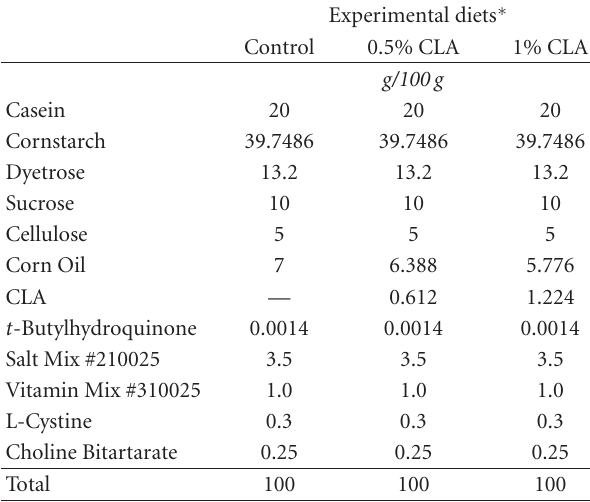
Table 1: Diet composition of experimental group.